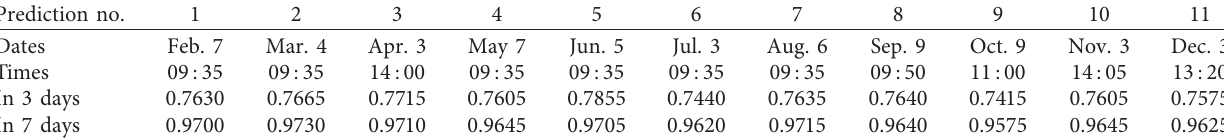
Table 6: Performances of the rolling window prediction of the SH composite index. Prediction no.